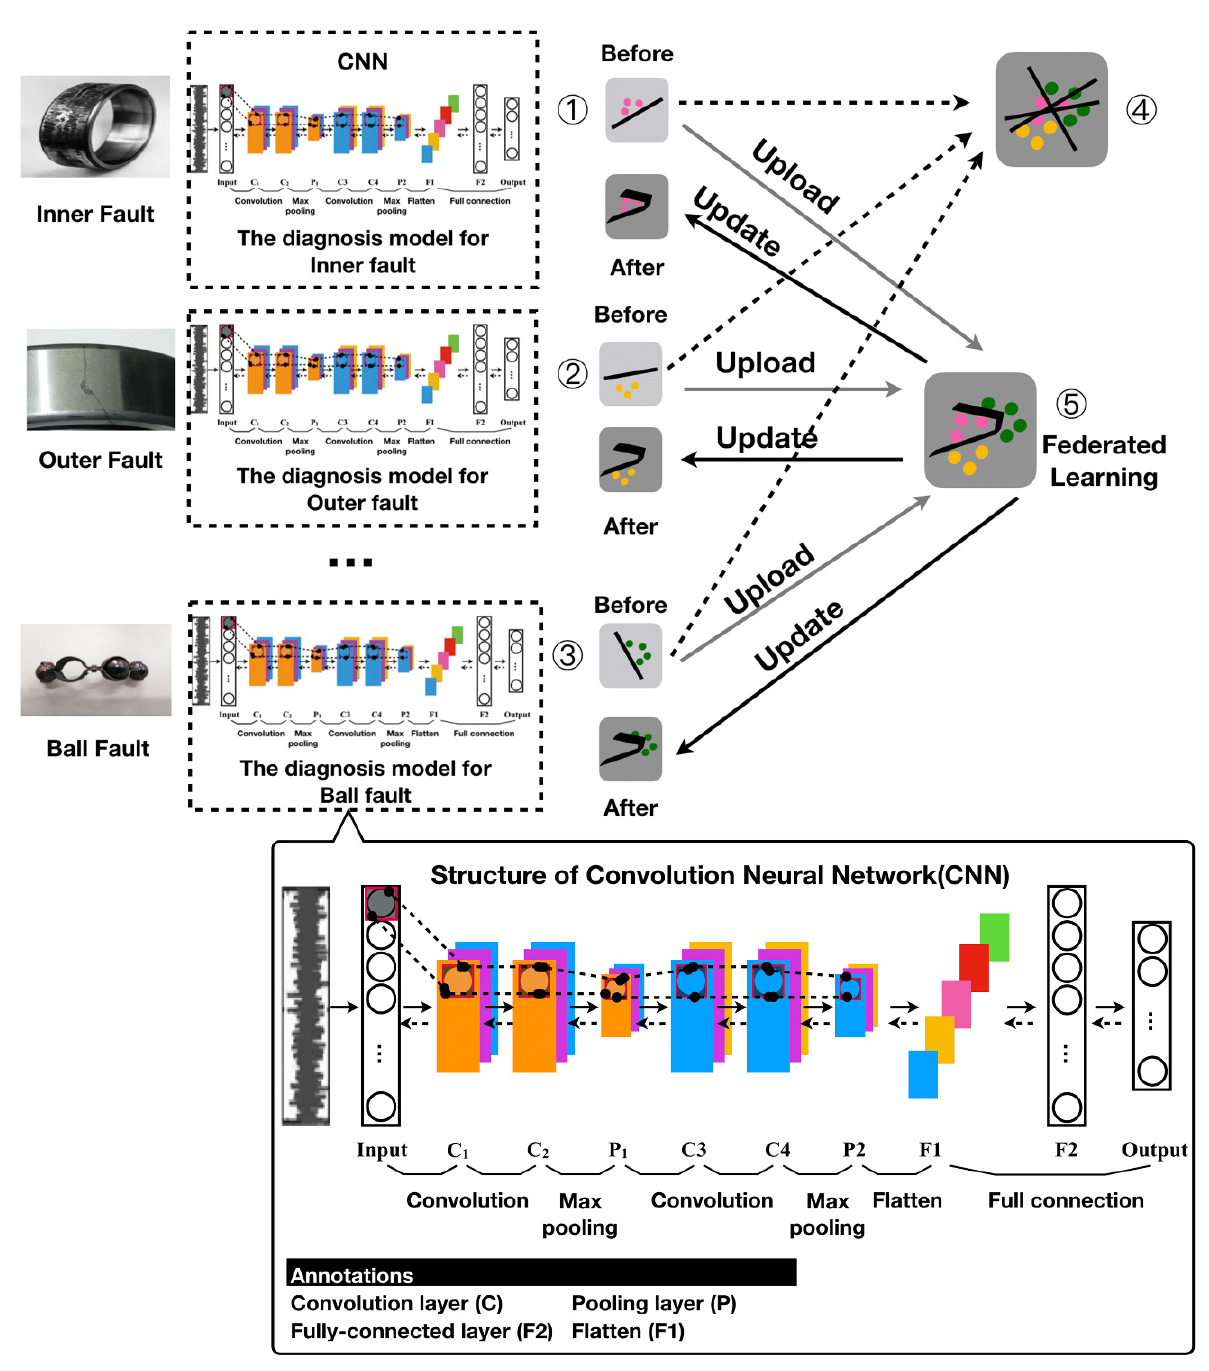
Figure 2. Architecture of federated fault diagnosis model.